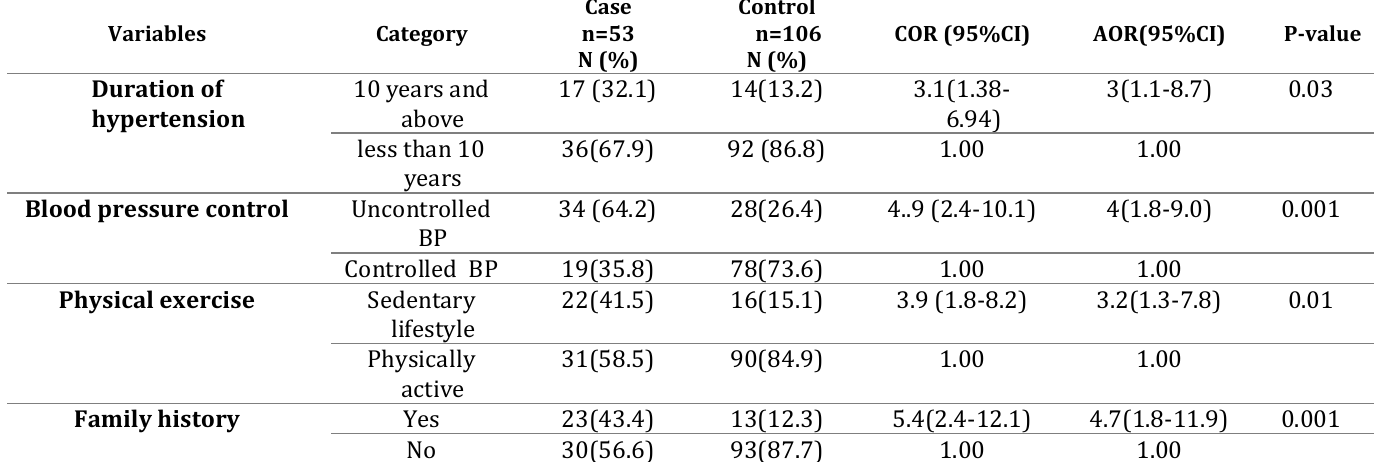
Table 4. Multivariable logistic regression output of predictors of hypertensive heart disease at Gondar University Referral Hospital during 2018